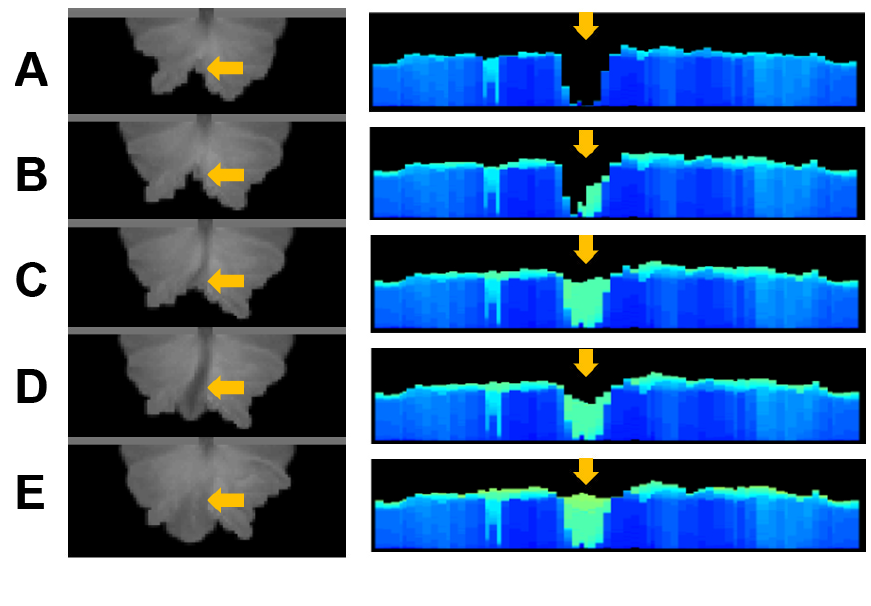
Figure 13. Time series of a delta produced by DeltaRCM with laboratory settings, and stratigraphy slices in the strike direction about 20 cells (0.4m) away from channel inlet. Note the evolution of the area pointed to by the yellow arrow. (a) A concave shoreline – empty space in stratigraphy; (b) channel begins to receive water and sediment – deposition begins; (c) more water and sediment switch to the channel – space is filled-up quickly; (d) full avulsion completed – a channel is established by water eroding existing deposits; (e) backfilling causes flooding and the channel loses its advantage – the channel is refilled and there is a discontinuity in deposition age (yellowish green in the upper portion and bluish green in the lower portion).